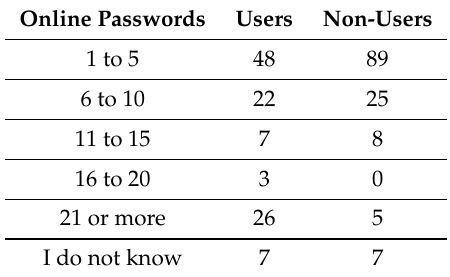
Table 19. Number of Passwords for 113 users and 134